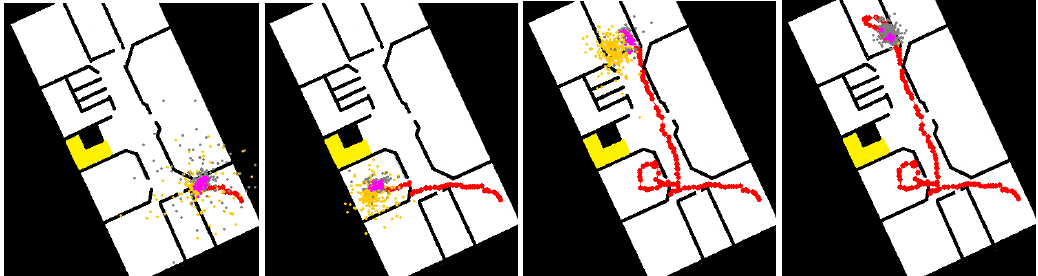
Figure 9. Particle filter algorithm progress over time (from left to right). The optical sensor data affected the orange particles, whereas the smartphone’s internal compass affected the gray particles. Having both particle types allows a more robust